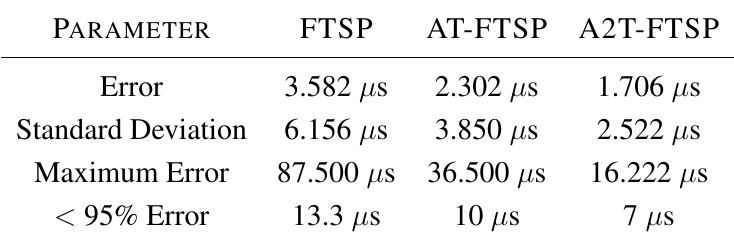
Table 4. Results with temperature variation: 22 ◦ C– 32 ◦